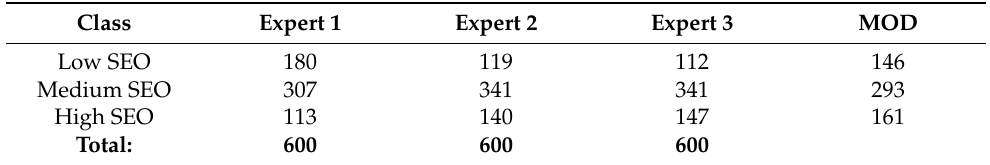
Table 2. The number of examples for each of the class values as labelled by three independent experts and the aggregated number of examples (the last column) based on majority voting of the labels from the three